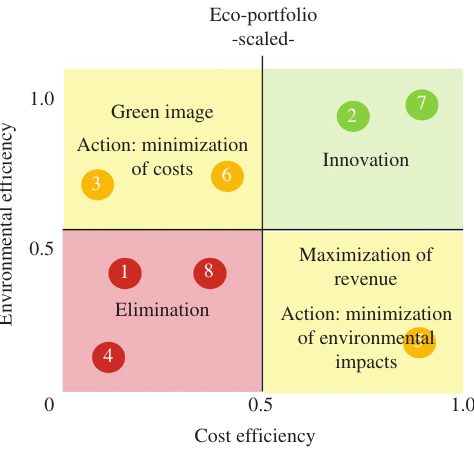
Figure 2 Eco-portfolio related to cost and environmental efficiency of alternative